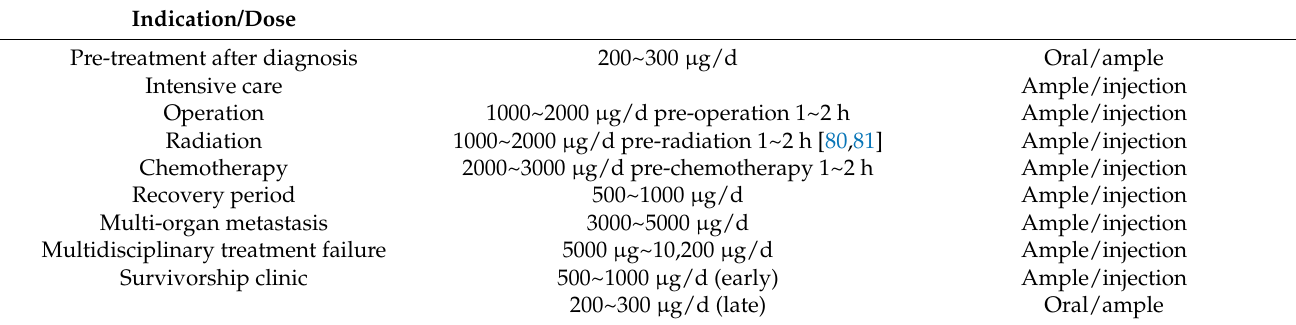
Table 1. Sodium selenite as integrative medical application to cancer patients at SIMCH.